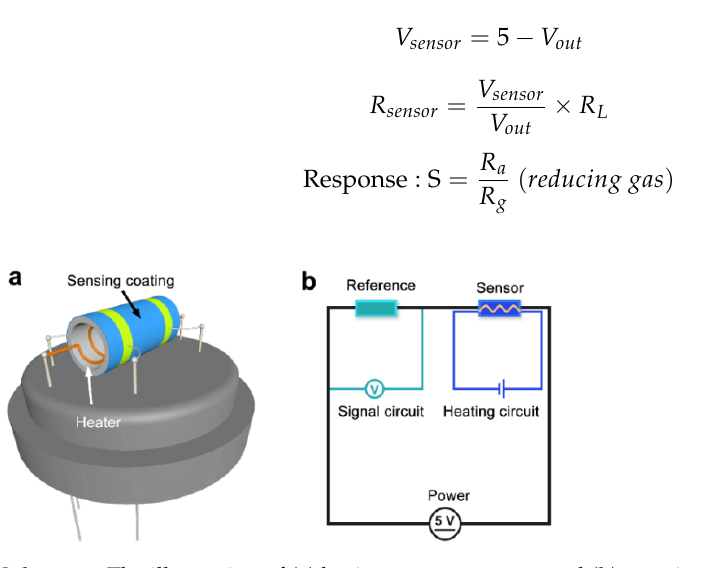
Scheme 2. The illustration of ( a ) basic sensor structure, and ( b ) test circuit.